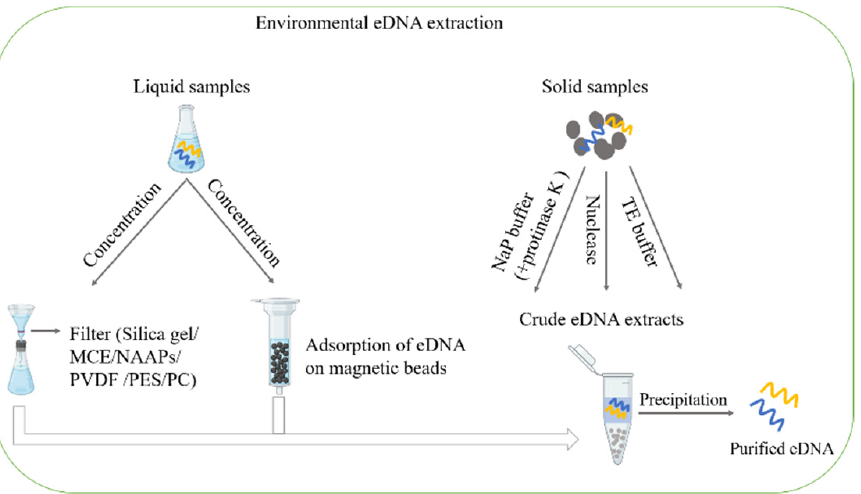
Figure 4. The methods of environmental eDNA extraction from liquid samples and solid samples. MCE: mixed cellulose acetate and cellulose nitrate; NAAPs: nucleic acid adsorption particles; PVDF: polyvinylidene fluoride filter; PES: polyether sulfone; PC: polycarbonate; NaP: sodium phosphate; TE: Tris EDTA.